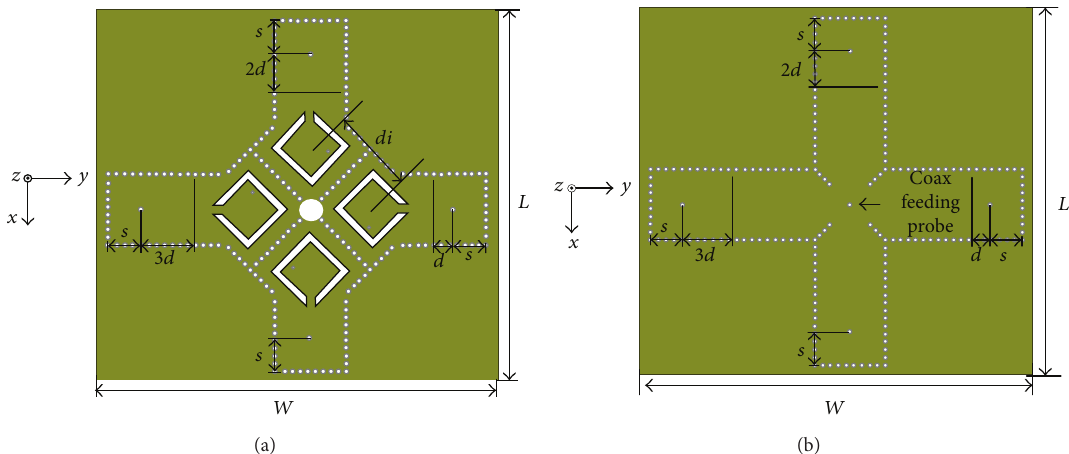
Figure 6: Layout of the 2 × 2 antenna array with (a) radiating patch on the top layer and (b) power divider on the bottom